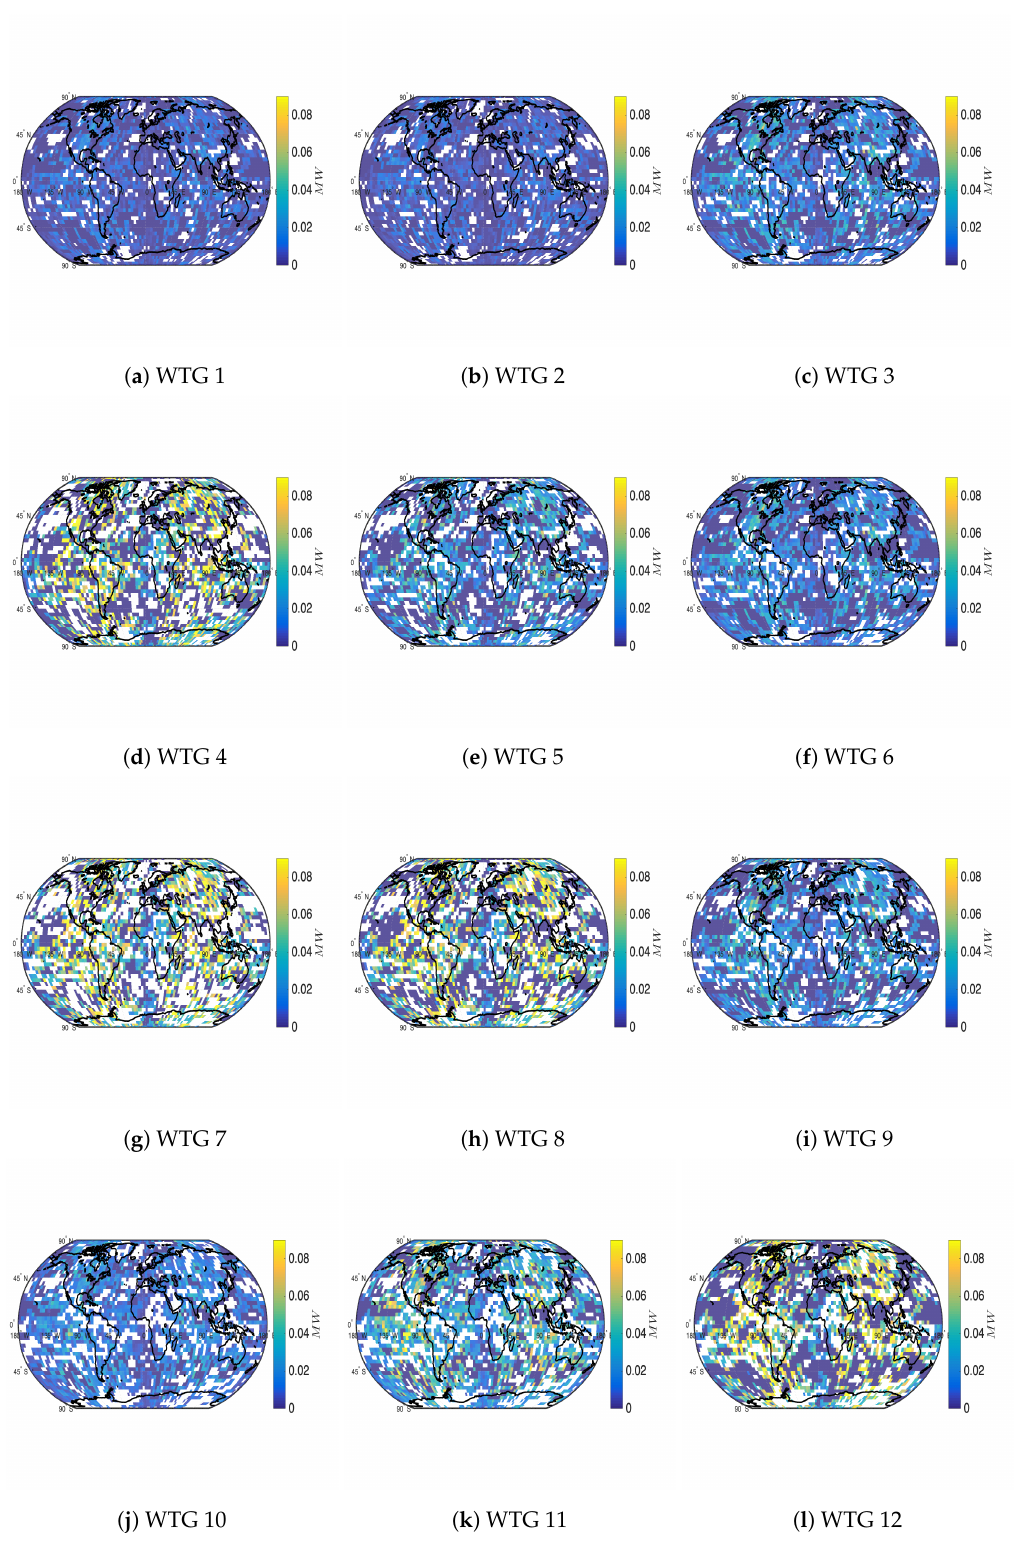
Figure 5. Mean of wind energy potentials for the 4D-Var-MC implementations. The number of ensemble members N = 20. White regions denote no wind-energy-potential generation. ( a ) WTG 1; ( b ) WTG 2; ( c ) WTG 3; ( d ) WTG 4; ( e ) WTG 5; ( f ) WTG 6; ( g ) WTG 7; ( h ) WTG 8; ( i ) WTG 9; ( j ) WTG 10; ( k ) WTG 11; ( l ) WTG